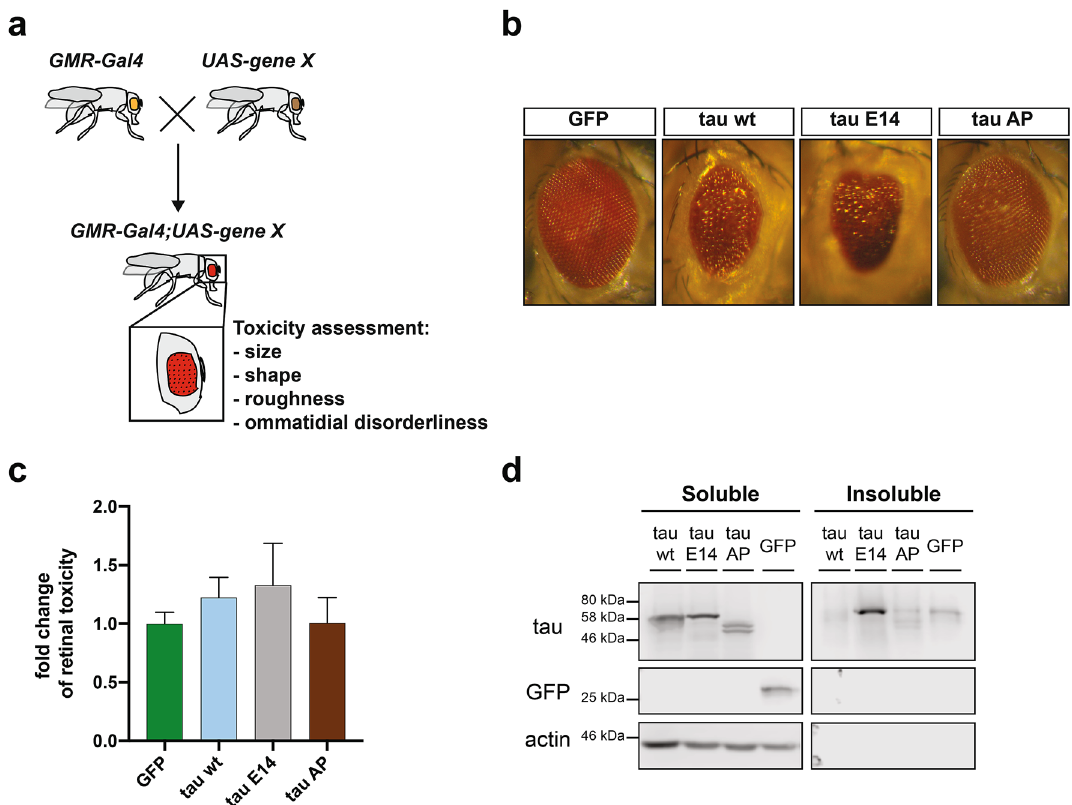
Figure 1. Tau hyperphosphorylation induces toxicity to Drosophila melanogaster upon expression in the retina. (a) Schematic illustration of the experimental setup and the parameters used to assess the toxicity in Drosophila retinal cells. (b) Representative images from Drosophila melanogaster eye phenotypes upon expression of different constructs under the GMR-Gal4 promoter element. (c) The severity of roughness in the eye phenotype was quantified using the Flynotyper ImageJ-based plugin and then normalized to the GFP control. Bars represent mean values ± s.d., n ≥ 6 animals/genotype were assessed. (d) Sarkosyl-soluble and insoluble fractions were isolated from transgenic Drosophila melanogaster brain homogenates and blotted against pan-tau and GFP, while actin was used as loading and assay quality